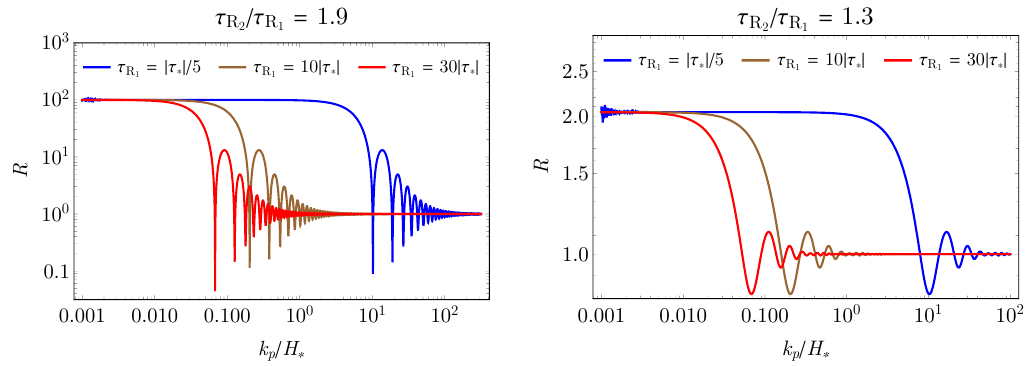
Figure 15 . The ratio R of ˜ E 0 defined in eq. (B.29), for τ R